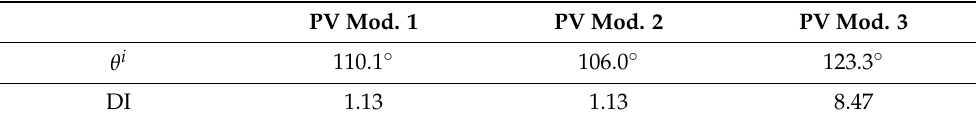
Table 3. Module orientation and DI (situation in which there is a horizontal fault in one of the trackers).